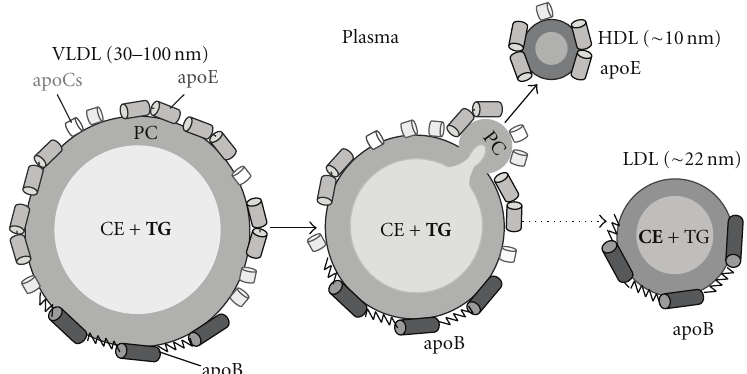
Figure 1: Cartoon showing metabolic remodeling of VLDL. Intact VLDL contain a core of apolar lipids, mostly triacylglycerides (TG) and some cholesterol esters (CE), surrounded by polar surface comprised mainly of phosphatidylcholines (PCs) and apolipoproteins. Exchangeable proteins, apoE (32kD) and apoCs (6–9kD), are comprised of amphipathic α -helical repeats and are shown in cylinders; the nonexchangeable apoB (550kD) contains domains with predominantly α -helical or β -sheet structure. VLDL remodeling in vivo starts with TG hydrolysis by lipoprotein lipase; this produces excess surface that dissociates in the form of apoE-containing particles that join the pool of HDL [3, 4]. Similar particles are formed upon other VLDL perturbations such as heating [20]. Remodeling of VLDL eventually converts them to LDL; each LDL contains one copy of apoB as its major protein. Dissociation of apoE and some lipids from the apoB-containing particles also occurs during endosomal degradation of VLDL